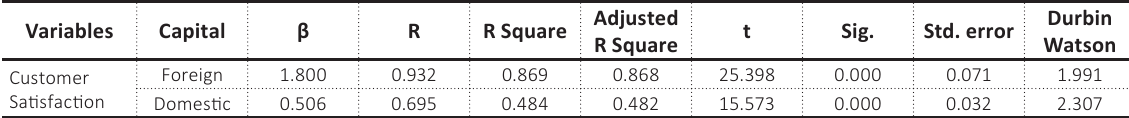
Table 6. OLS model according to the categorization of banks for service quality and customer satisfaction Variables